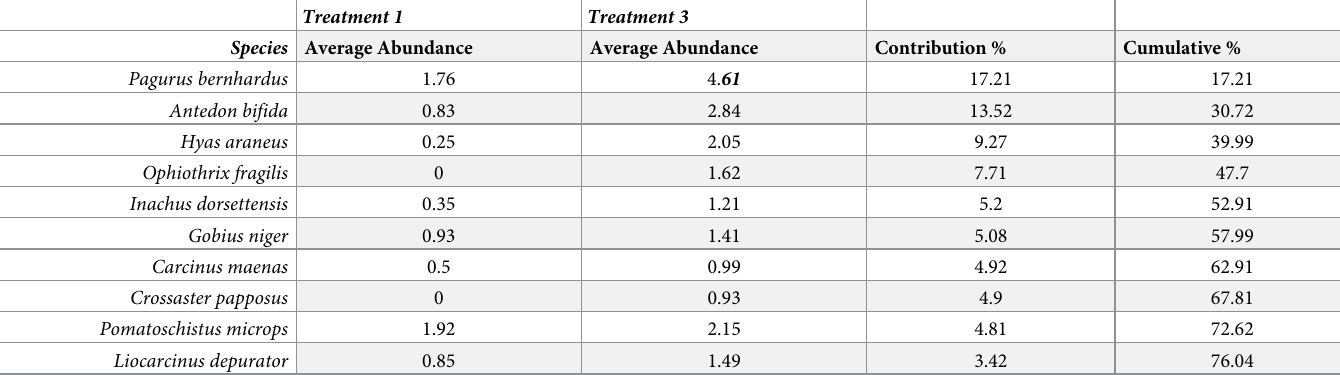
Table 1. SIMPER analysis comparing percentage dissimilarity between Treatment site 1 and Treatment site 3.